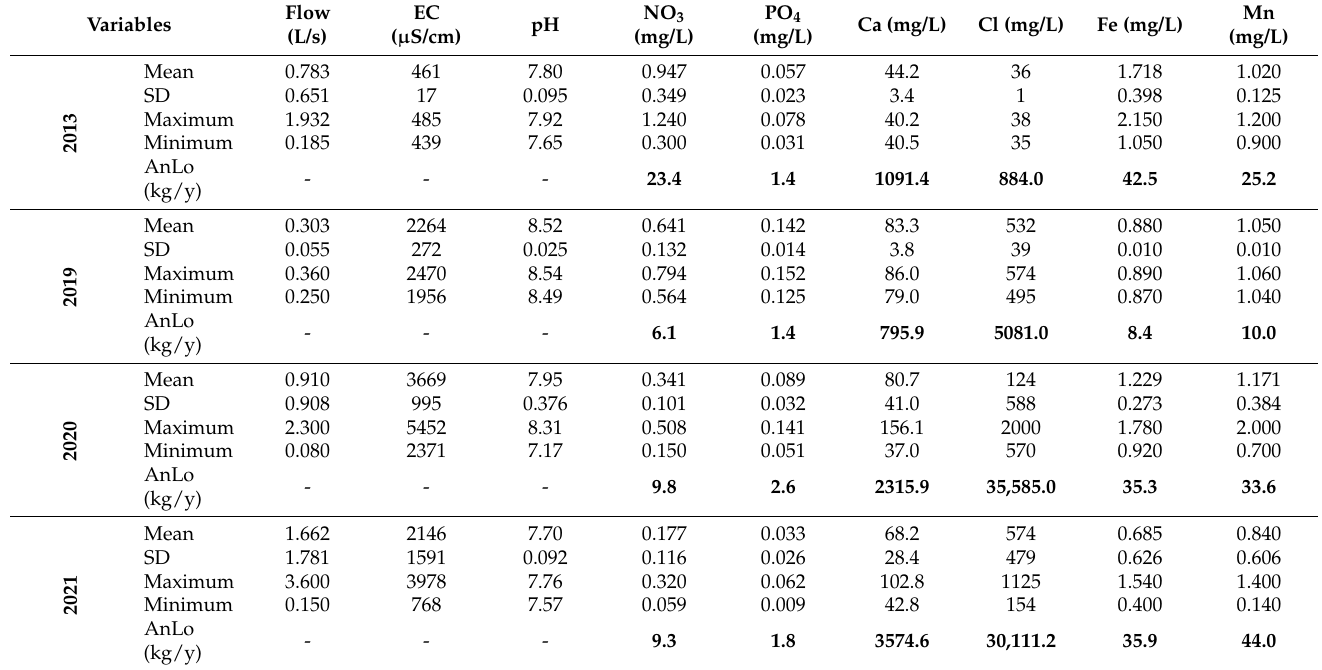
Table 2. Characteristics of the selected parameters of rainwater flowing into Lake